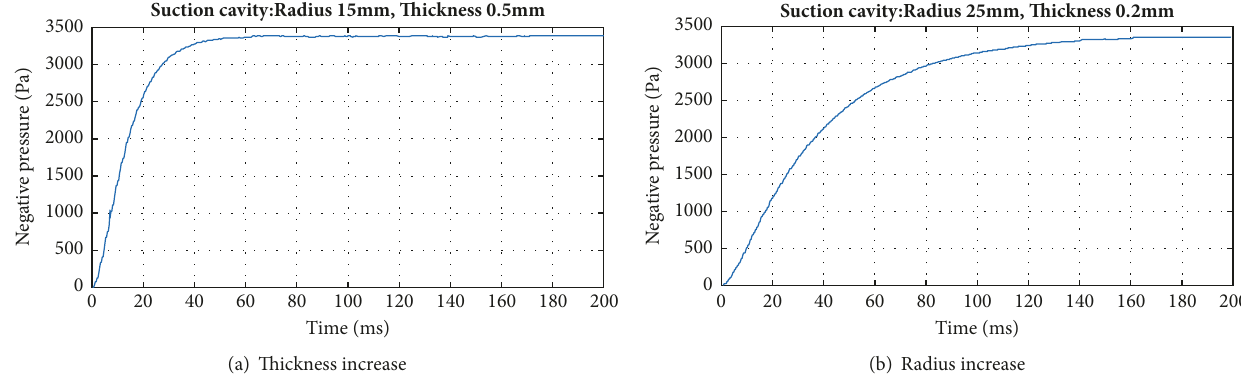
Figure 20: Influence of suction cavity on negative pressure